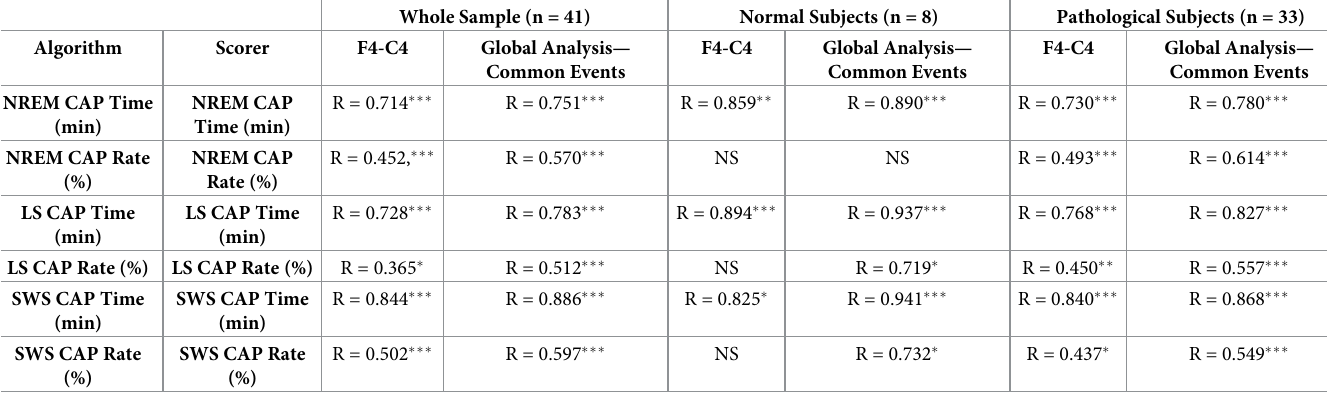
Table 5. Pearson’s correlations.